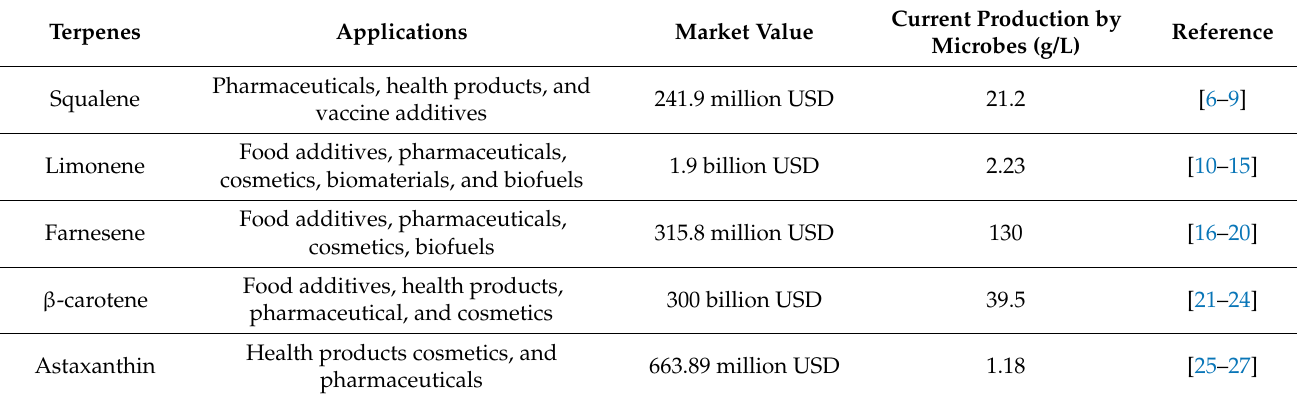
Table 1. The potential applications and market values of partial